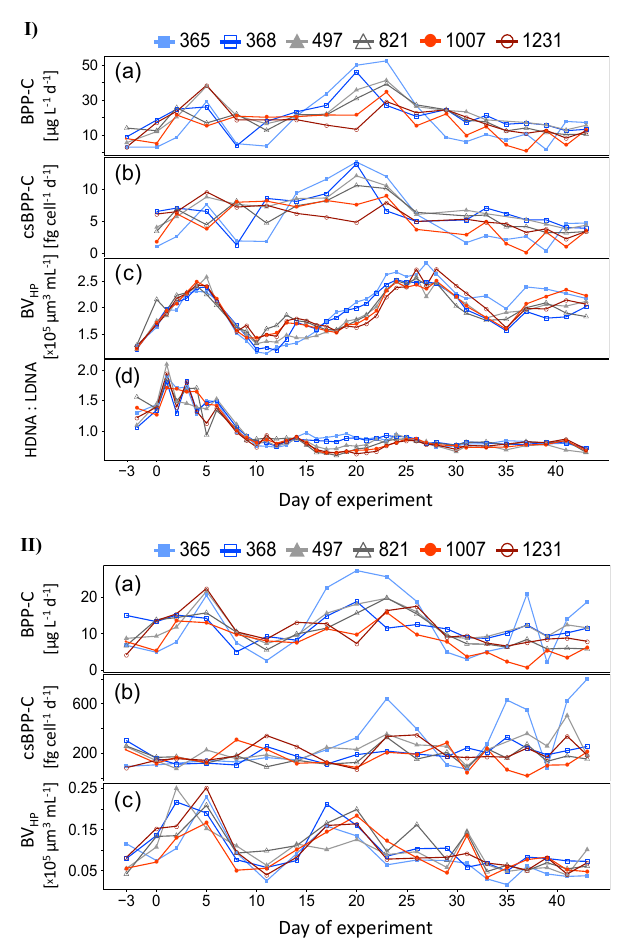
Figure 1. I: Free-living (0.2–5.0µm) and II: particle-associated ( > 5 . 0µm), size-fractionated rates of (a) bacterial protein pro- duction (BPP) [µgCL − 1 d − 1 ] as well as (b) cell-specific bac- terial protein production (csBPP) [fgCcell − 1 d − 1 ] and (c) het- erotrophic prokaryotic biovolume (BV HP ) [ × 10 5 µm 3 mL − 1 ] dur- ing the course of the experiment. I: (d) Ratio of high vs. low nucleic acid-stained prokaryotic heterotrophs (HDNA:LDNA). Colours and symbols indicate average f CO 2 [µatm] between t 1 − t